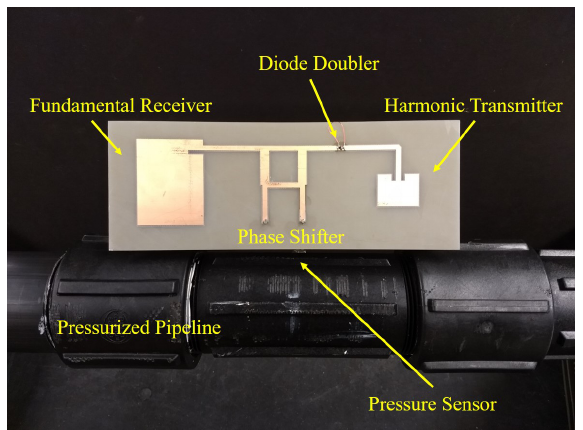
Figure 12. Pressurized polypropylene pipeline setup with the fabricated harmonic RF sensor tag for real-time wireless